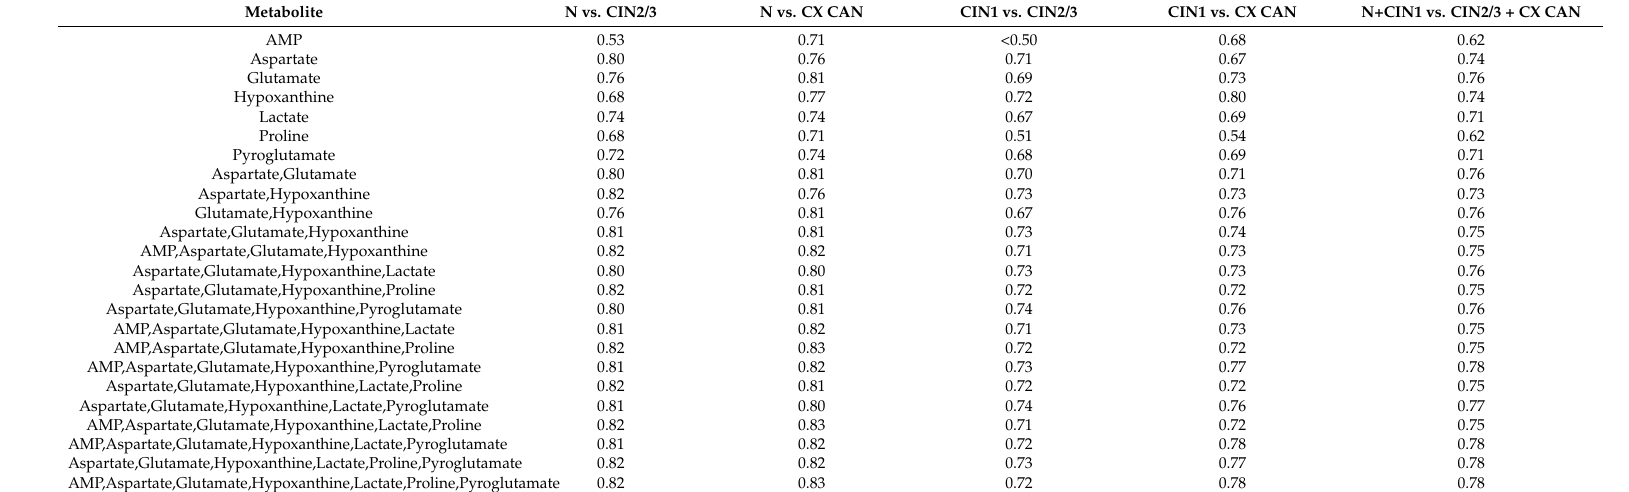
Table 2. Area under the curves (AUCs) among normal, CINs, and cervical